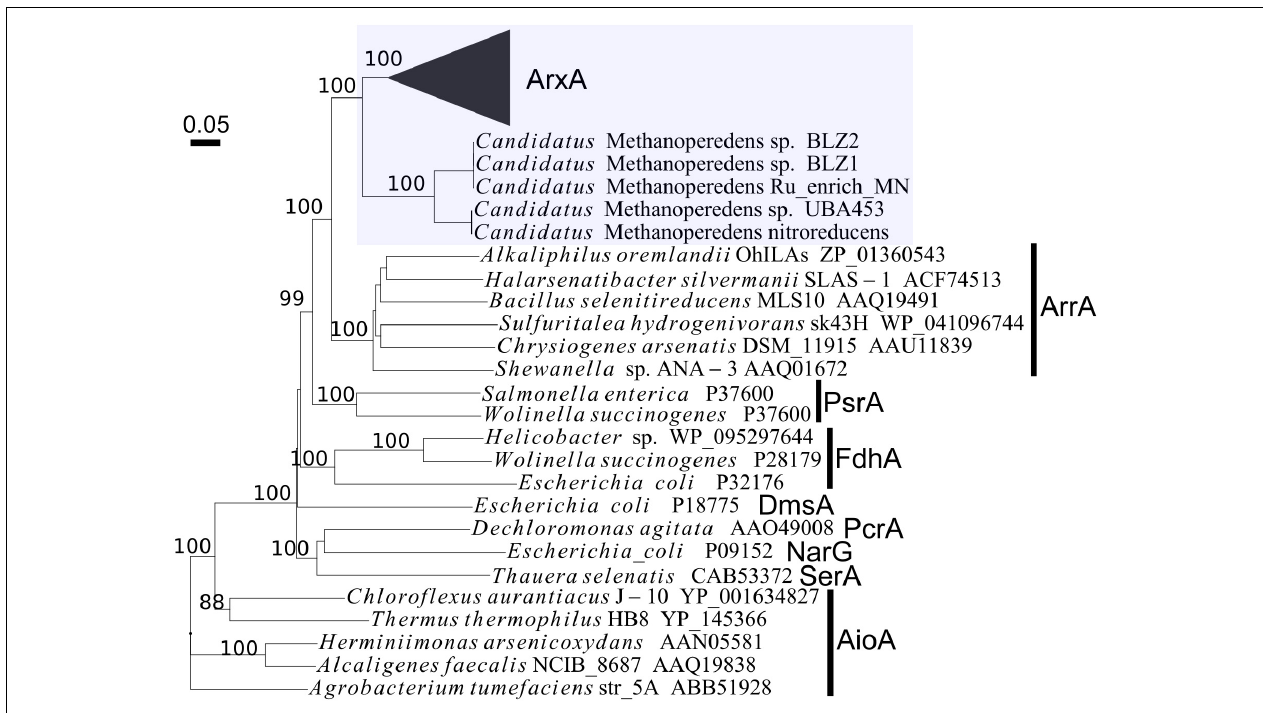
FIGURE 5 | Phylogenetic positions of proteins homologous to ArxA of Alkalilimnicola ehrlichi MLHE-1, within the DMSO reductase family proteins. The ArxA of A. ehrlichi MLHE-1 and its homologs identified by BLAST searches are highlighted with a shaded box. An uncollapsed version of this tree is presented in Supplementary Figure S1 . PsrA, polysulfide reductase; FdhA, formate dehydrogenase; DmsA, dimethyl sulfoxide reductase; SerA, selenate reductase; NarG, respiratory nitrate reductase; PcrA, perchlorate